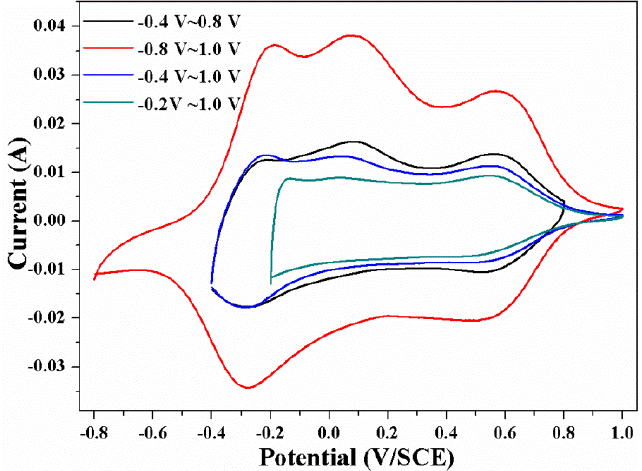
Figure 6. CV curves of the VO 2 (B) nanobelts at different potential limit (20 mV ∙ s − 1 , 1 M Na 2 SO 4